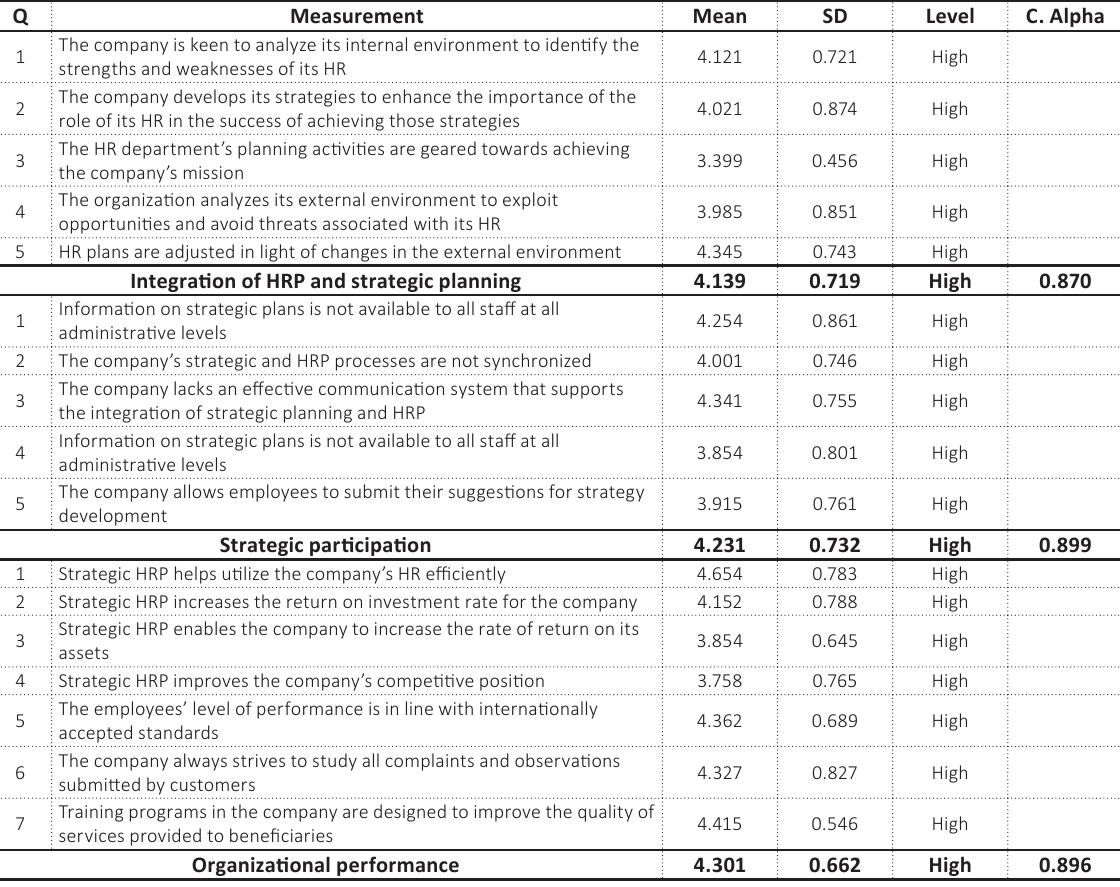
Table 2. The constructs’ measurements: means, standard deviations, and reliability